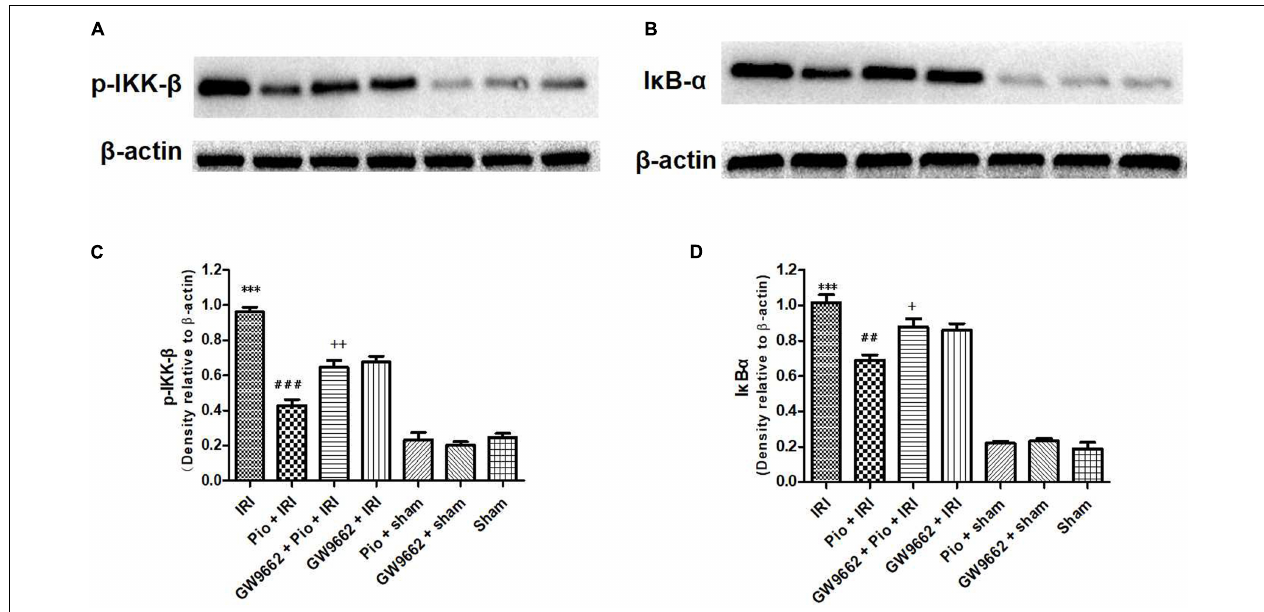
FIGURE 5 | Pioglitazone down-regulates p-IKK- β and I κ B- α protein expression at 24 h after renal IRI. (A,B) Representative western blots show p-IKK- β and I κ B- α protein expression in the kidneys. (C,D) Quantitative analysis of p-IKK- β and I κ B- α protein expression in the kidneys. Values are expressed as mean ± SE ( n = 4). Compared to the sham group, ∗∗∗ represents p < 0.001; compared to the IRI group, ## represents p < 0.01, and ### represents p < 0.001; compared to the Pio + IRI group, + represents p < 0.05, and ++ represents p < 0.01.